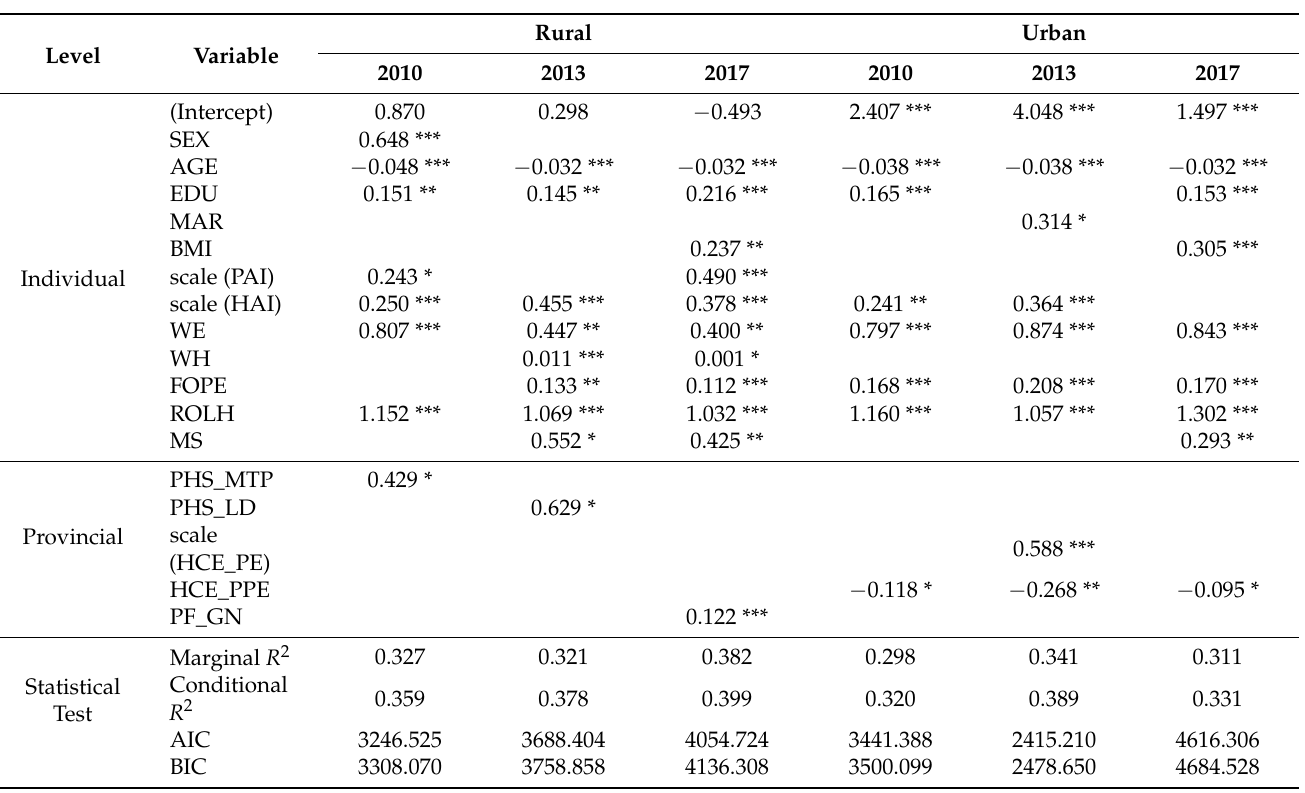
Table 5. The results of the HLM